Question: How would you classify this visualization?
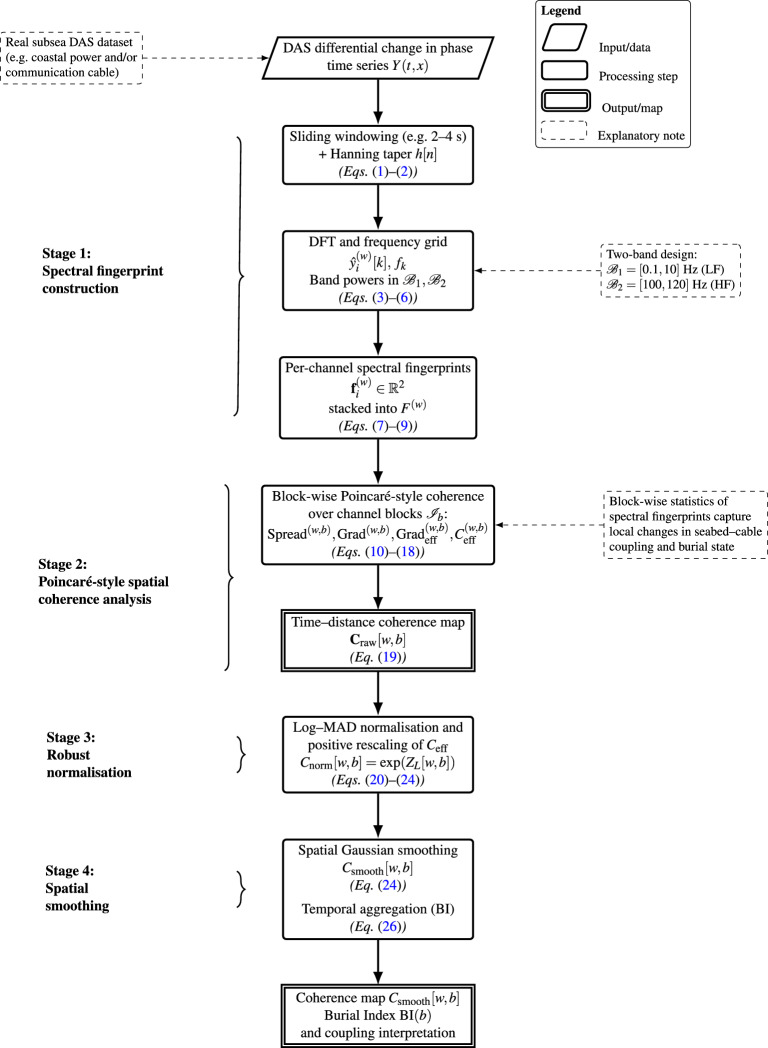
Answer: line